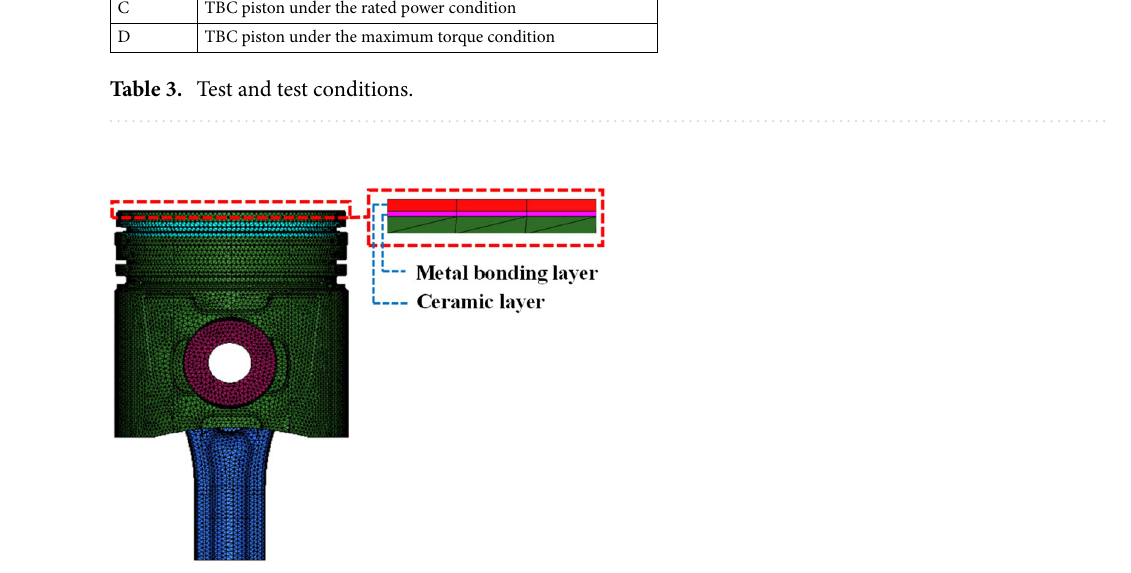
Figure 3. Piston finite element model and amplification